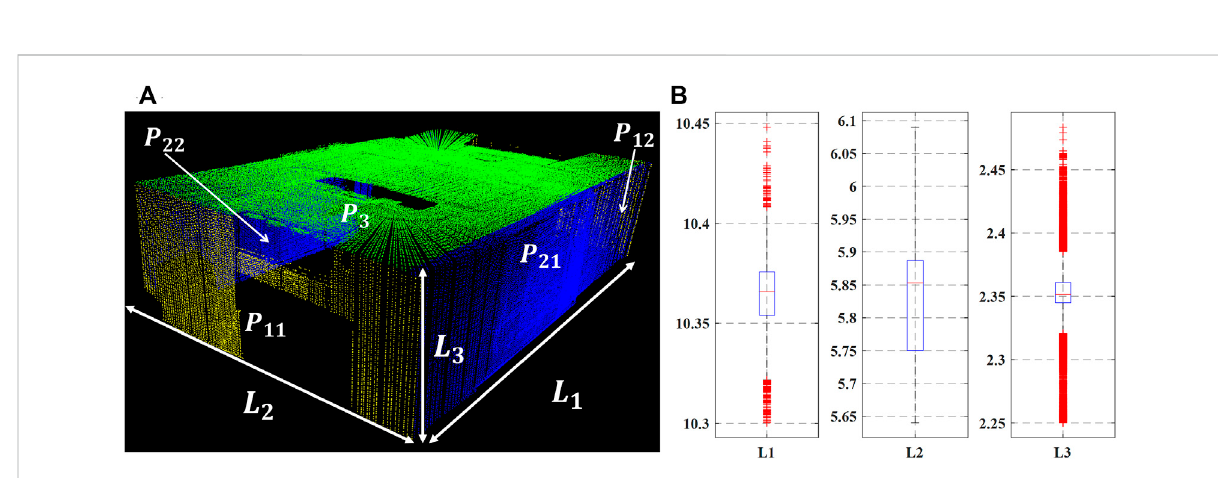
FIGURE 12 Accuracy results (A) plane segmentation results (B) measurement statistical results shown in